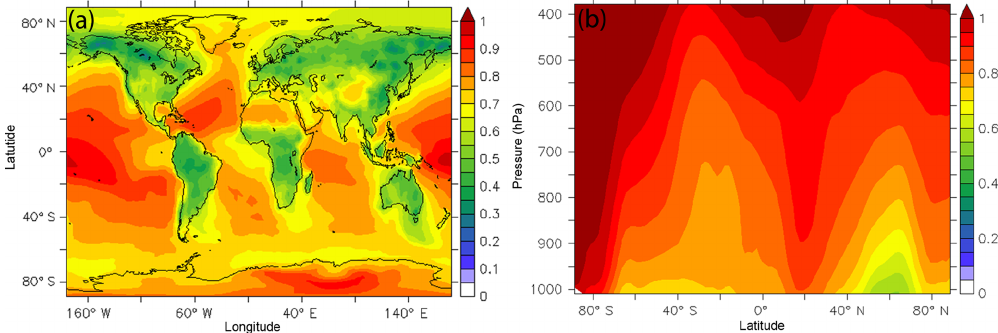
Figure 3. Predicted average (a) surface and (b) zonal O:C of total OA during the years 2001–2010.